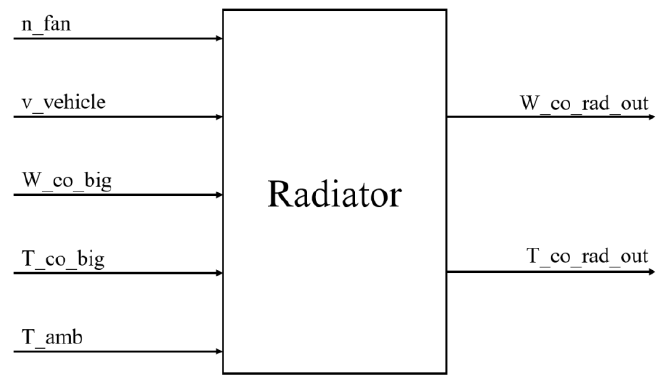
Figure 7. The input and output of the radiator model.